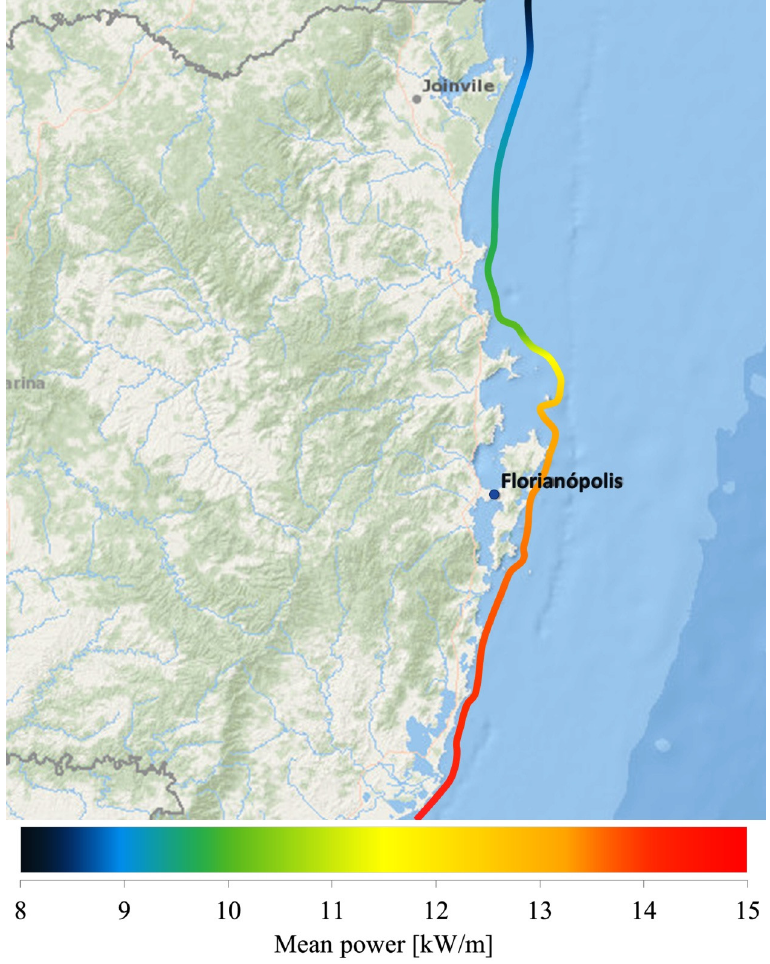
Figure 14. Mean wave power flux per unit crest on north ‐ central Santa Catarina coastline on 20 m ‐ isobaths.